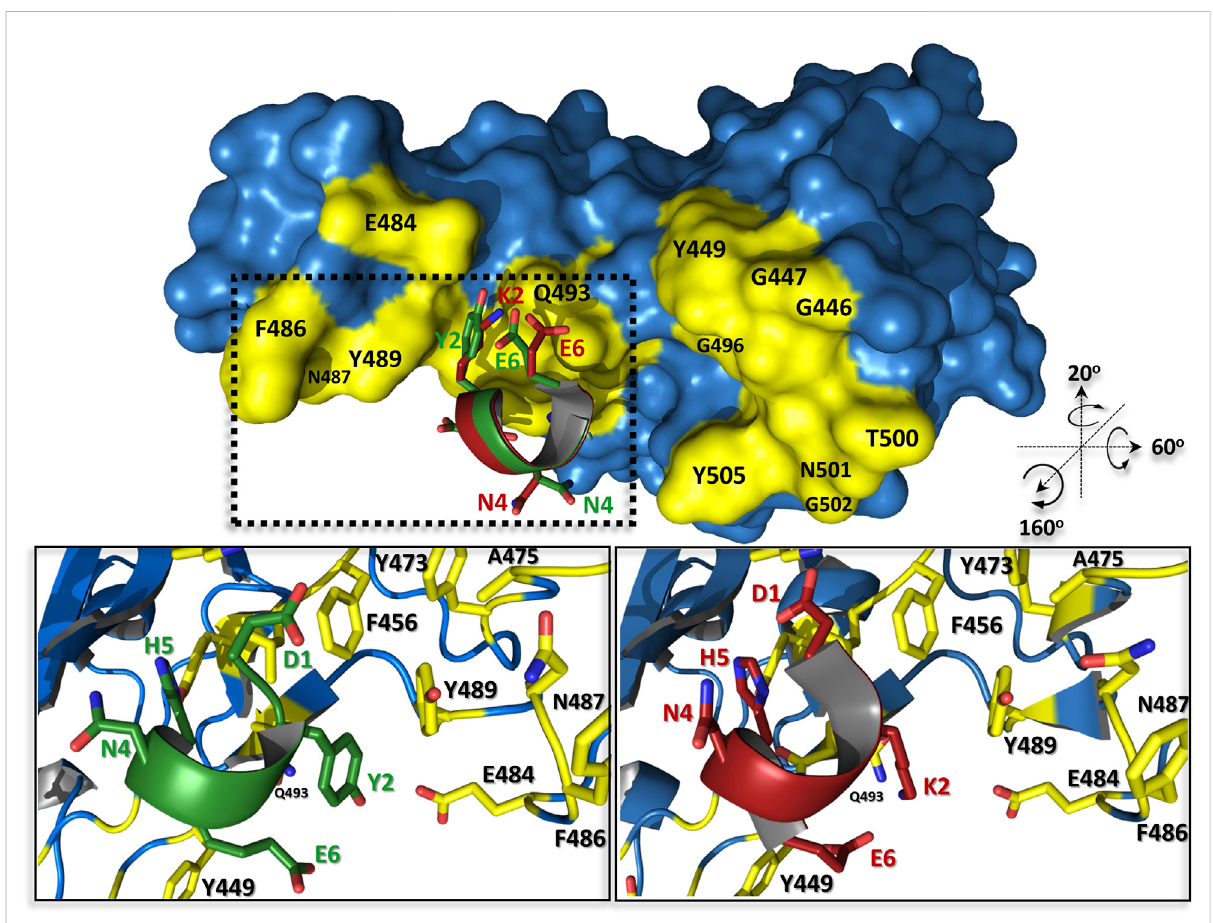
FIGURE 5 The predicted complex structures of peptides pep1d (red) and J3 (green) with SARS-CoV-2 spike receptor-binding domain (blue). Residues creatinginteractioninterfaceareawith h ACE2arecolouredyellow.Detailedviewofinteractionsbetweenpep1d(lowerrightpanel)andJ3(lowerleft